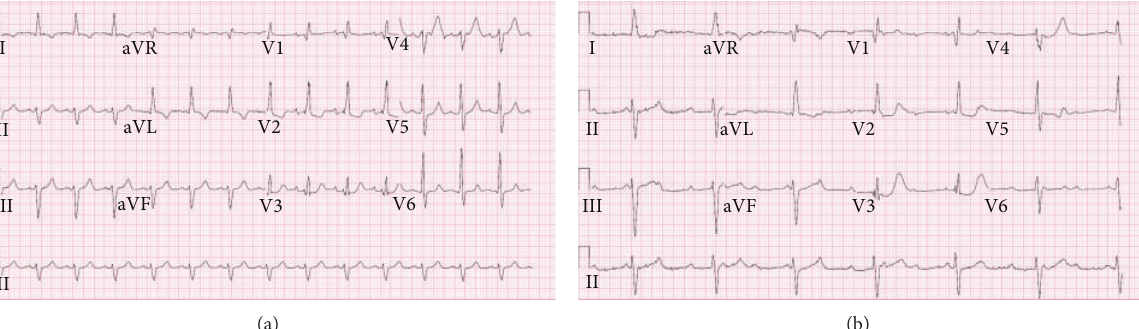
Figure 2: The EKG 4 years before presentation (a) with right bundle branch block with left anterior hemiblock; then progression to complete heart block accompanying the enlargement of thrombosed sinus of Valsalva aneurysm